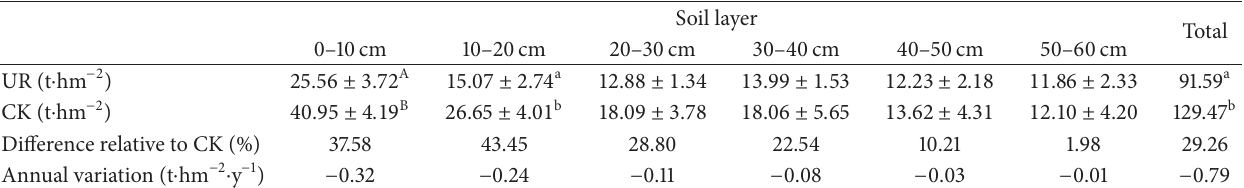
Table 4: Comparison of soil carbon storage in different stands (mean ± SD, 𝑛 =